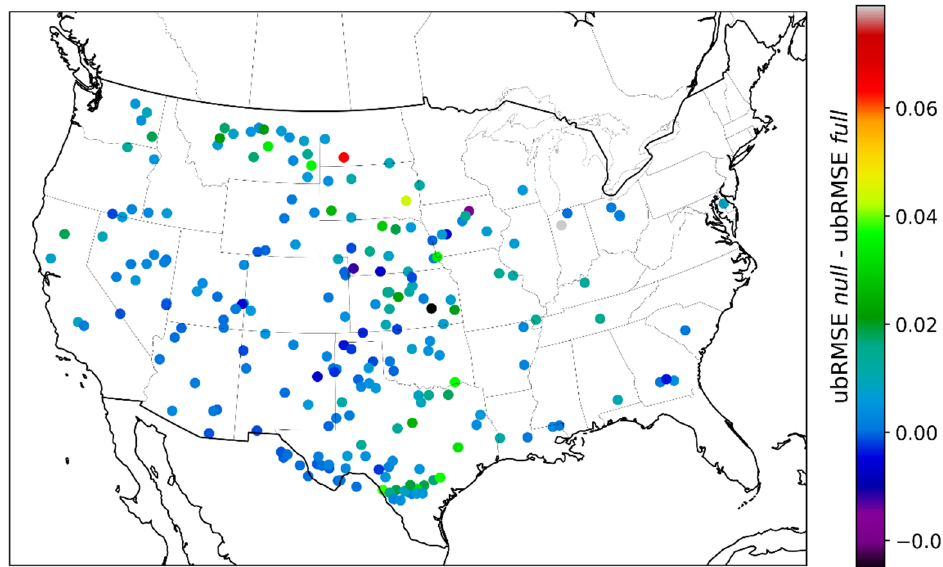
the LAI prediction.